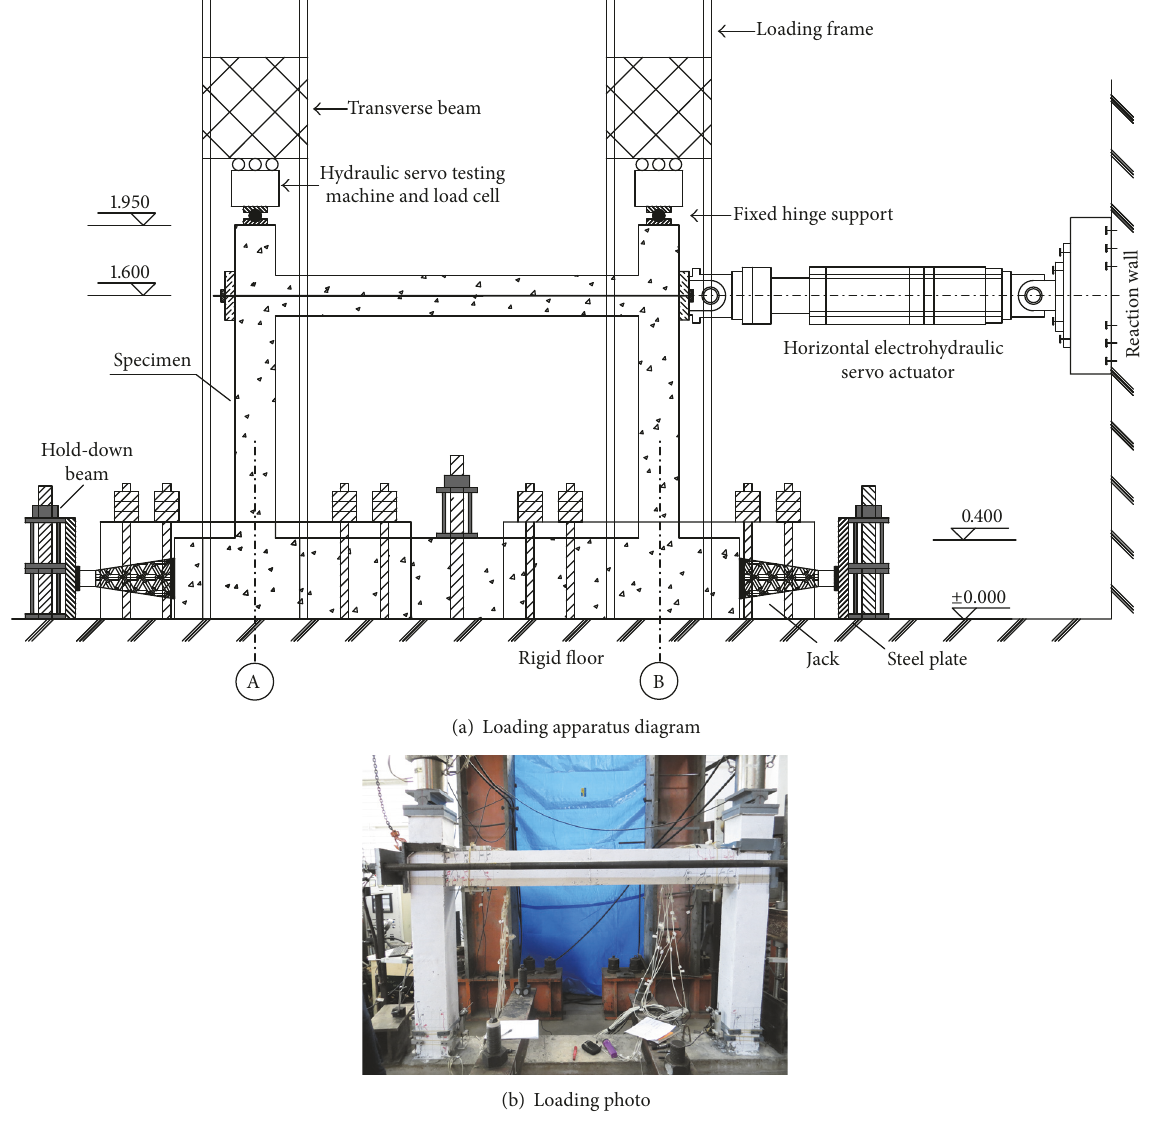
Figure 3: Loading apparatus and photo.